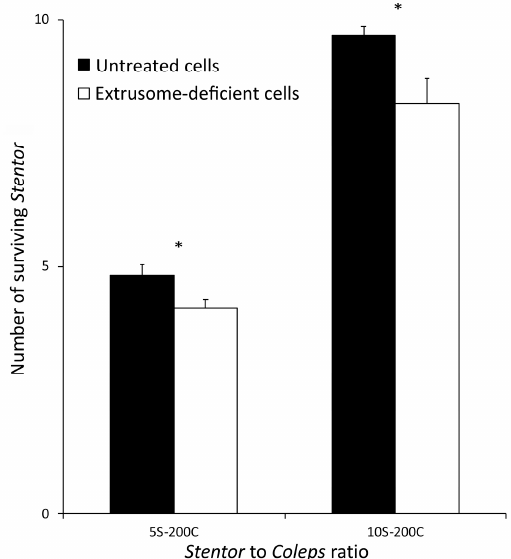
Figure 3. Effect of the extrusome deprivation in S. polymorphus on the predator-prey interaction with C. hirtus. Groups of five or 10 cells of either extrusome-deficient or untreated cells of S. polymorphus were mixed with groups of 200 cells of C. hirtus (the 5S-200C and 10S-200C, respectively). Each bar represents the mean ( ± SE) of six independent experiments. * p <